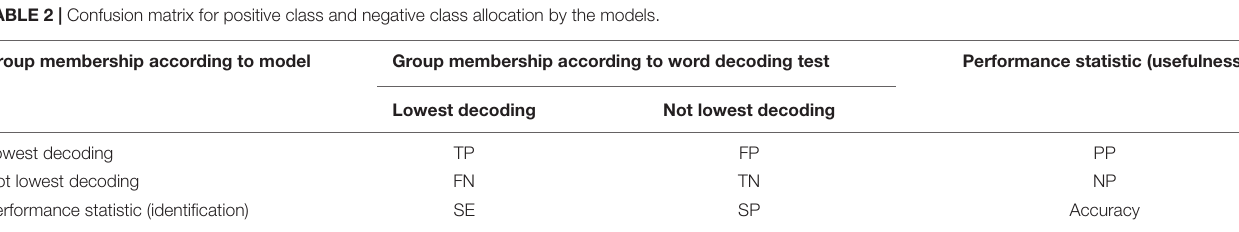
FIGURE 1 | Schematic overview of conducted studies and aims, research questions, and model building techniques that were involved. RQ, research question. TABLE 2 | Confusion matrix for positive class and negative class allocation by the models.